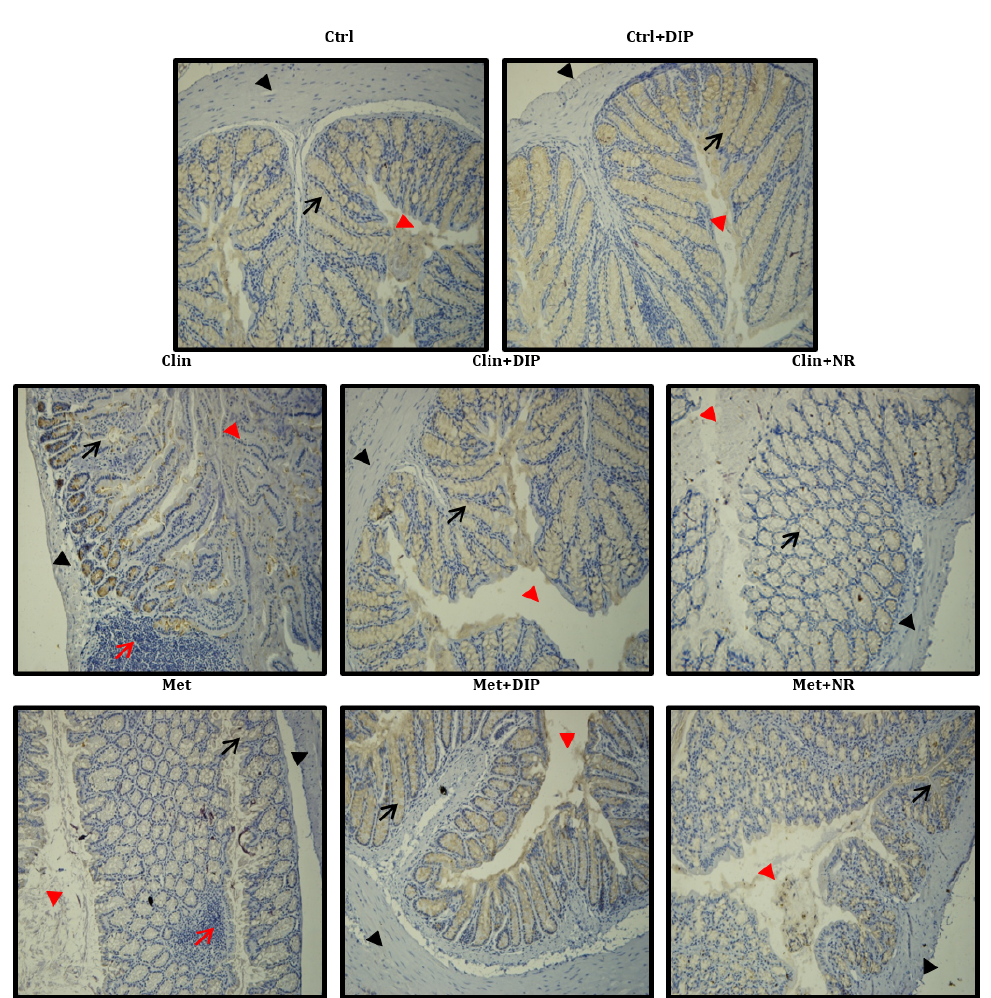
Figure 9. Representative immunohistochemistry staining for Mucin ‐ 2 in the colon of eight different treatment groups. Shown are mucin expression (indicated with black arrows), inflammatory cells (red arrows), the mucosal space (red arrow head), and the epithelium surface (black arrow head). Original magnification × 20, Scale bar: 100 μ m.